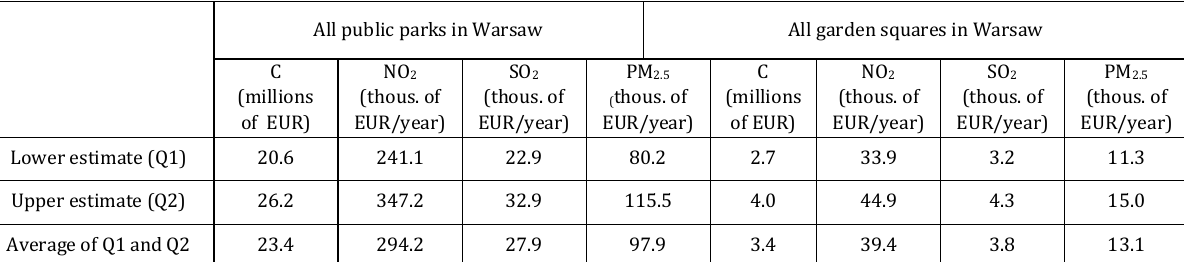
Table 6. Results of data extrapolation for the whole of the Warsaw area All public parks in Warsaw All garden squares in